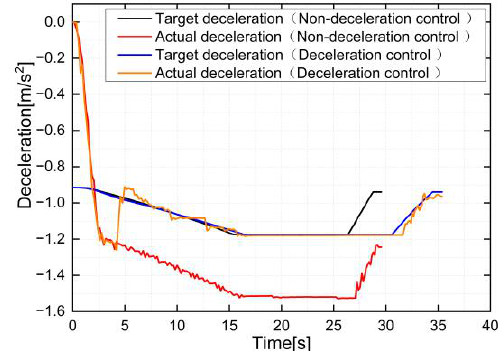
Figure 12. Test result with an uncertain load.